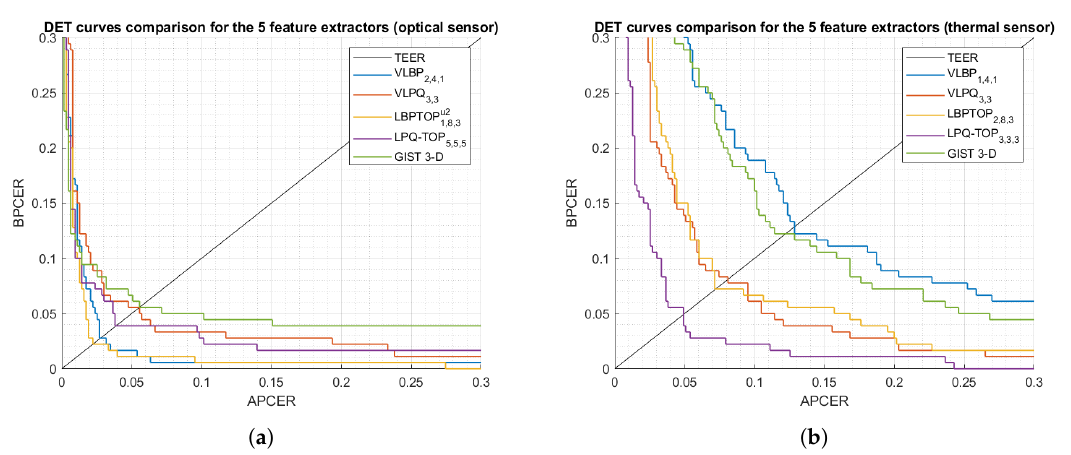
Figure 7. DET curves comparison of the proposed PAD subsystem using five feature